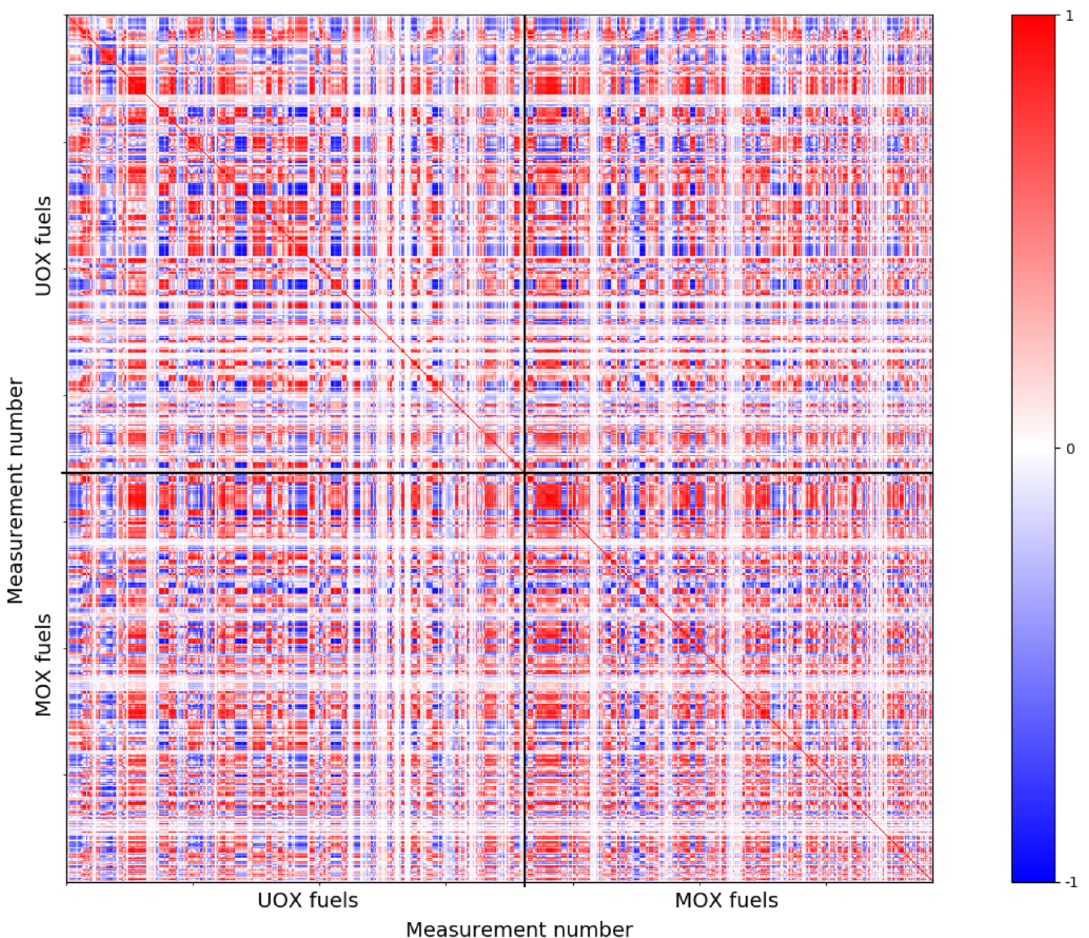
Fig. 4. Correlation matrix between calculated-to-experimental isotopic ratios used for the assimilation